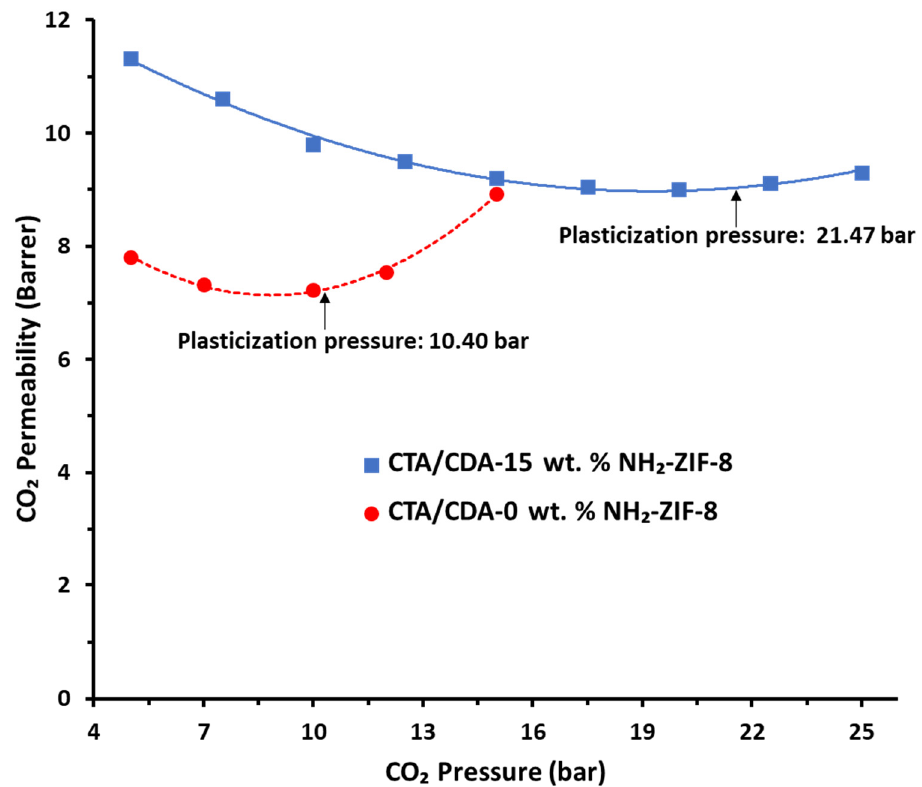
Figure 9. CO 2 plasticization behavior of the pristine CTA/CDA-0 wt.% NH 2 -ZIF-8 blend membrane and CTA/CDA-15 wt.% NH 2 -ZIF-8 blend MMM. Figure 9. CO ₂ plasticization behavior of the pristine CTA/CDA-0 wt.% NH ₂ -ZIF-8 blend mem-